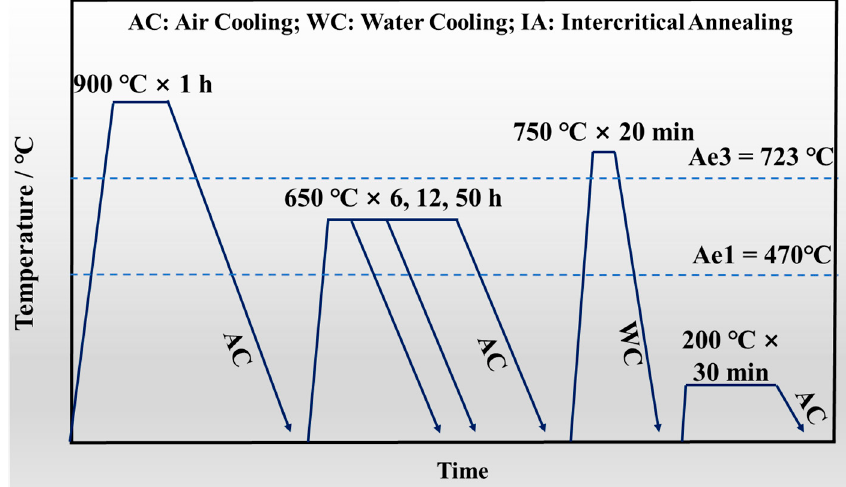
Figure 2. Schematic diagram of the heat treatment process.